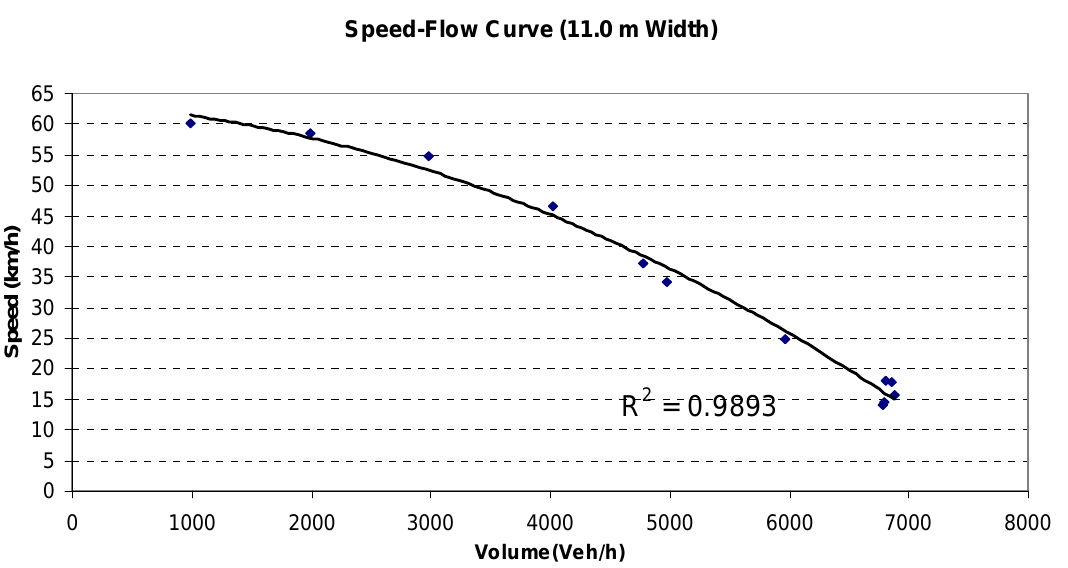
Figure 8. Speed flow curve for 11 m wide urban